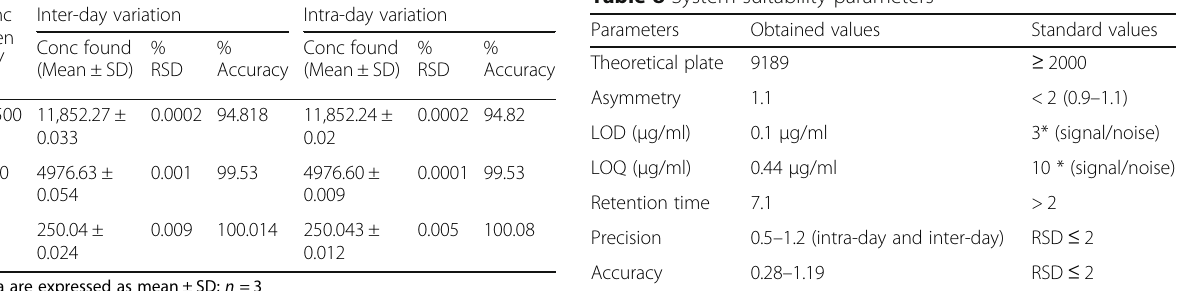
Table 8 System suitability